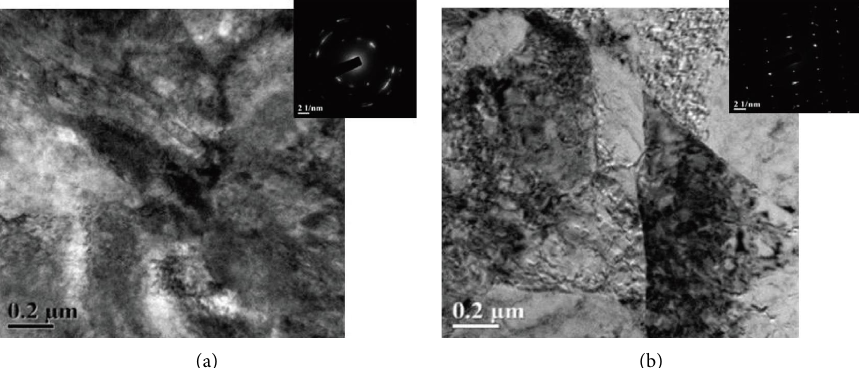
Figure 7: Te microstructure of the billet after TE and the frst stage of rolling ( h � 9.7mm, heating is 350 ° S ): (a) rolling the central part of the sample after the TE; (b) rolling the edge part of the sample (without complete processing with